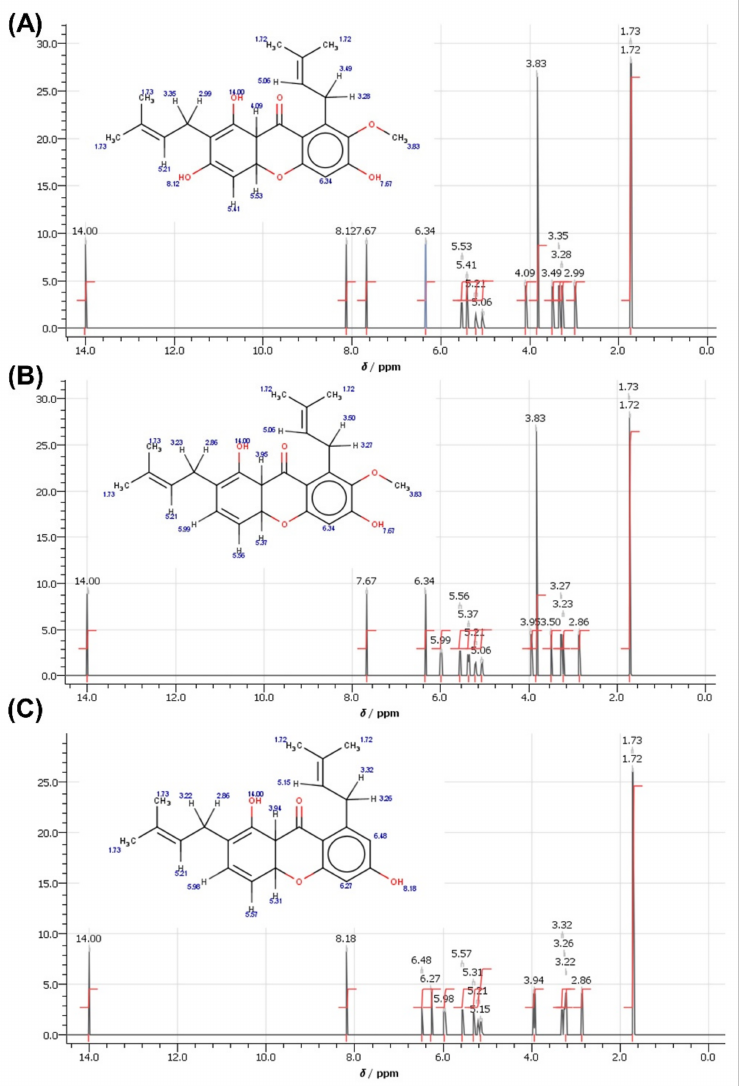
Figure 6. The predicted 1H NMR spectra for ( A ) alpha-mangostin, ( B )